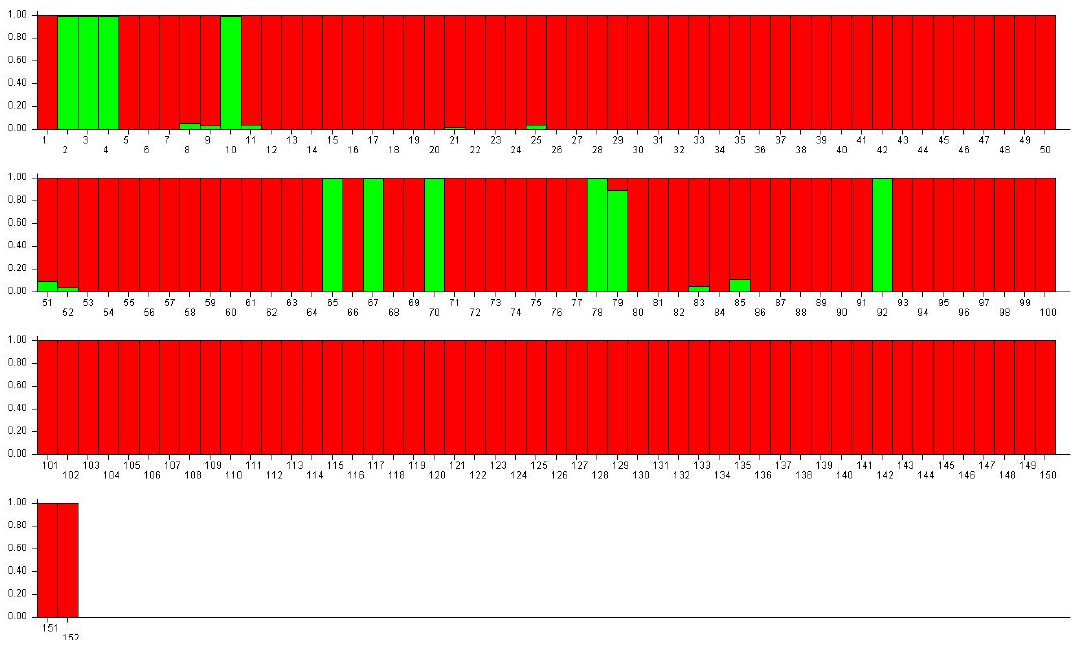
Figure 2. Assignment model of 152 black amaranth samples at the K = 2 genetic clusters by using nine SSR markers (Cluster 1 in red and Cluster 2 in green). Membership coefficients ( Q ) are depicted vertically for each sample. Sample numbers coincide with the number assigned in Supplementary Table S1.